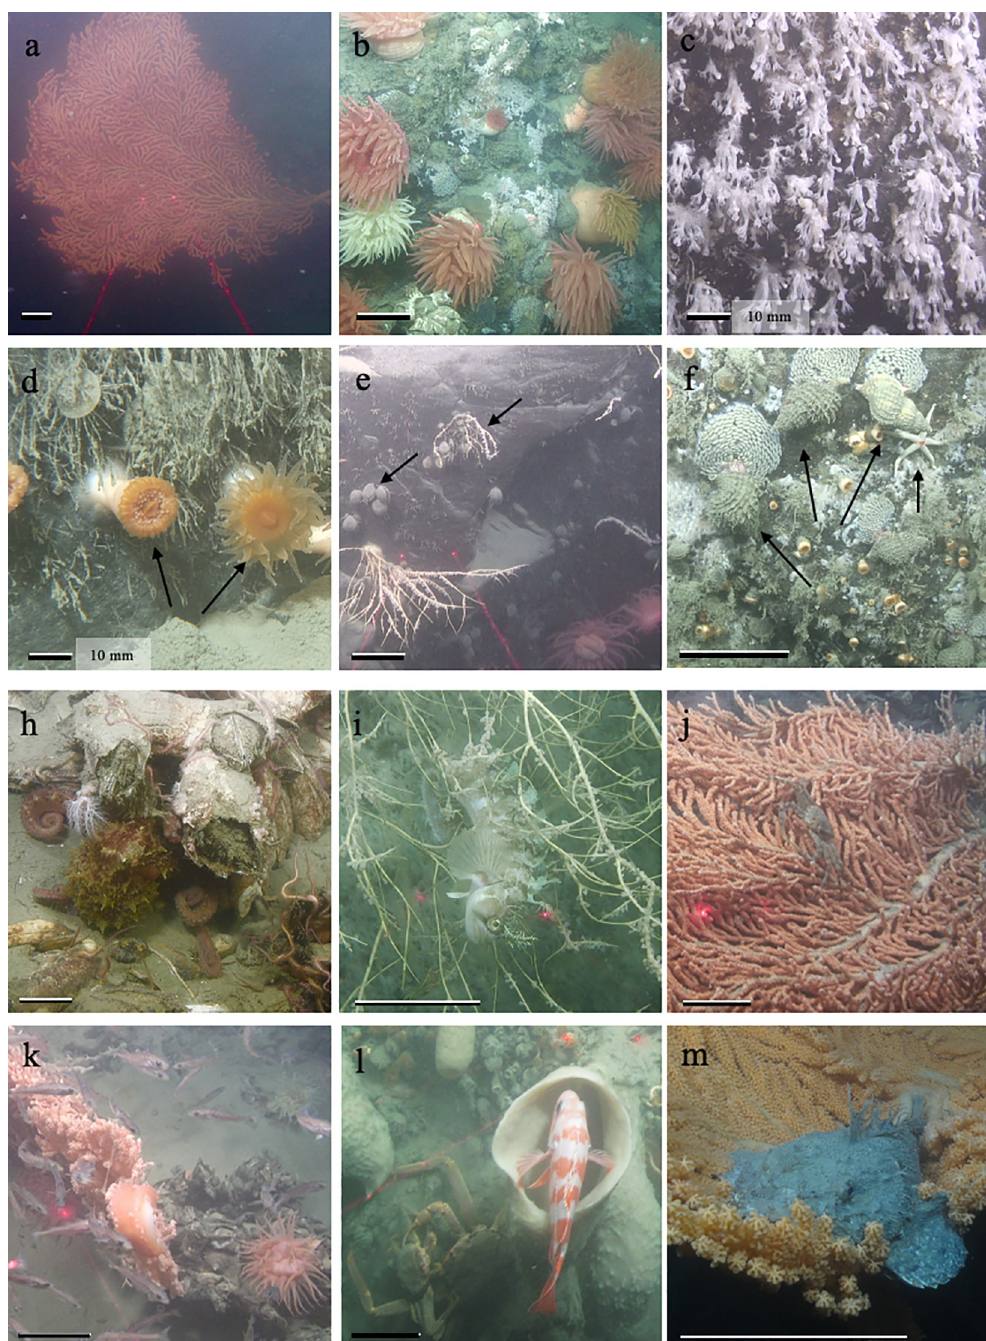
Fig 3. Exemplar epifaunal taxa observed. (a) large Primnoa pacifica colony (b) anemones Cribrinopsis sp. (c) encrusting stoloniferan coral Sarcodyction incrustans (d) close up of hydrozoan turf and arrows point to solitary cup coral Caryophyllia arnoldi (e) arrows point to small ( < 0.25 m) P . pacifica colony and brachiopods Laqueus californicus (f) arrows point to the snails Fusitriton oregonensis laying egg capsules as well as a blood star Henricia sp.–there are also C . arnoldi in this image. (h) Brittle star ( Ophiopholis sp.) arms and an octopus, Enteroctopus dofleini , under barnacles, Chirona evermanni (i) decorated warbonnet Chirolophis decorates amongst branches of a P . pacifica colony (j) snow crab Chionoecetes sp. in a large P . pacifica colony (k) P . pacifica colony with an aggregation of juvenile Pacific cod Gadus macrocephalus , also in the image are barnacles ( C . evermanni ), an anemone ( Cribrinopsis sp.), and the predatory nudibranch Tritonia diodema (l) red banded rockfish Sebastes babcocki over demospongiae and two snow crabs ( Chionoectes sp.) (m) bigmouth sculpin Hemitripterus bolini stationary on edge of P . pacifica branches. Scale bars are 10cm unless otherwise